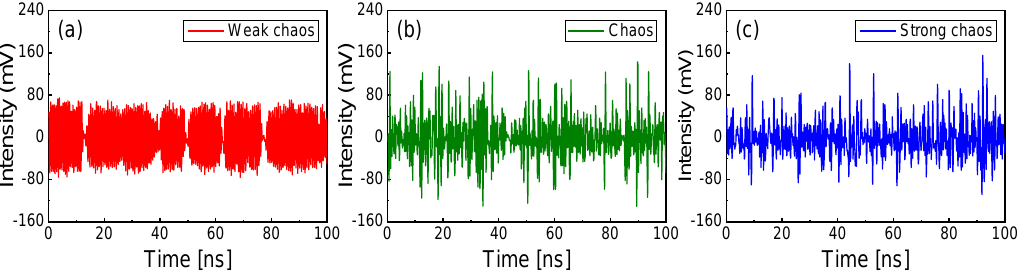
Figure 3. Measured three corresponding time series of the chaotic laser. The bias current J = 1.5Jth and feedback strength ( a ) η = 2.66%, ( b ) 8.87%, ( c ) 30.31% are the same as those used in Figure 2.